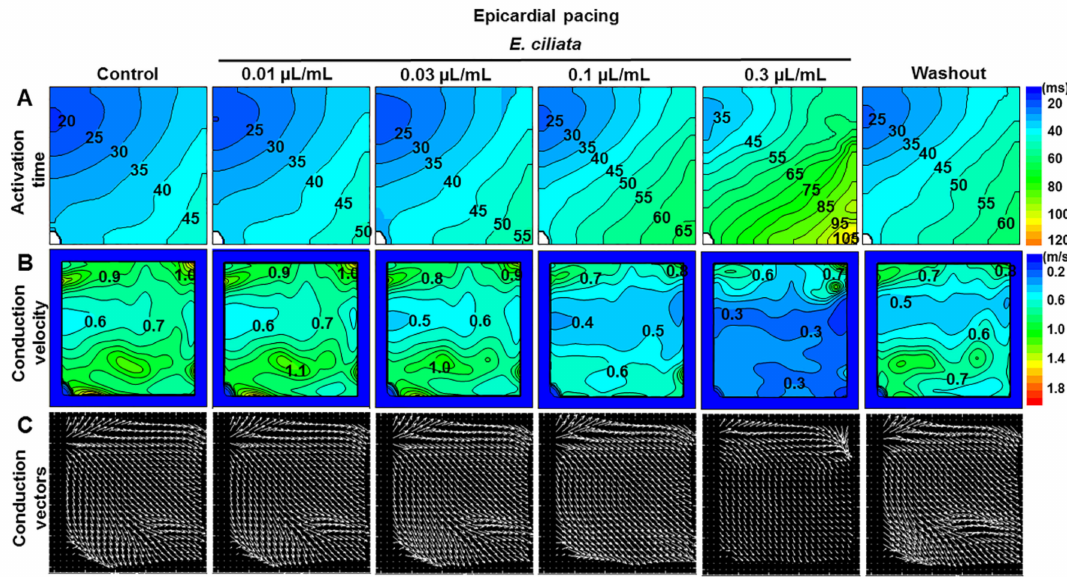
Figure 7. Optical maps revealing E. ciliata e ff ects on electrical activation process in the heart during epicardial stimulation. A voltage-sensitive fluorescent dye, di-4-ANBDQBS, was used. The pacing period was 300 ms. ( A ) Activation time (in ms), ( B ) conduction velocity (in m / s), and ( C ) conduction vector maps in the control and after applying 0.01, 0.03, 0.1, and 0.3 µ L / mL concentrations of the E. ciliata , followed by a washout period. The interval between isochrones is 5 ms for the activation time, 0.1 m / s for the conduction velocity. Note that the conduction vector length is proportional to the conduction velocity. The direction of the activation wave movement is from blue-green to red. The stimulation electrode was located on the left close to the LV base.